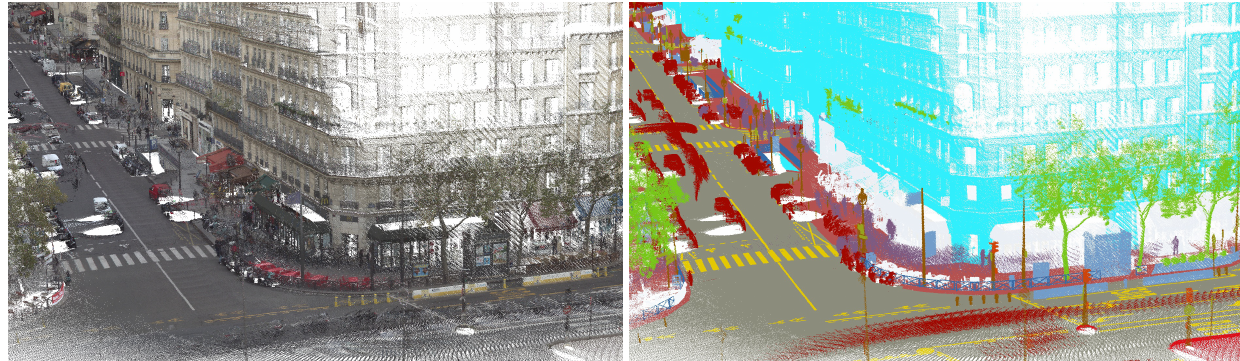
Figure 2. Paris-CARLA-3D dataset: ( left ) Paris point clouds with color information on LiDAR points; ( right ) manual semantic annotation of the LiDAR points (using the same tags from the CARLA simulator). We can see the large number of details in the manual